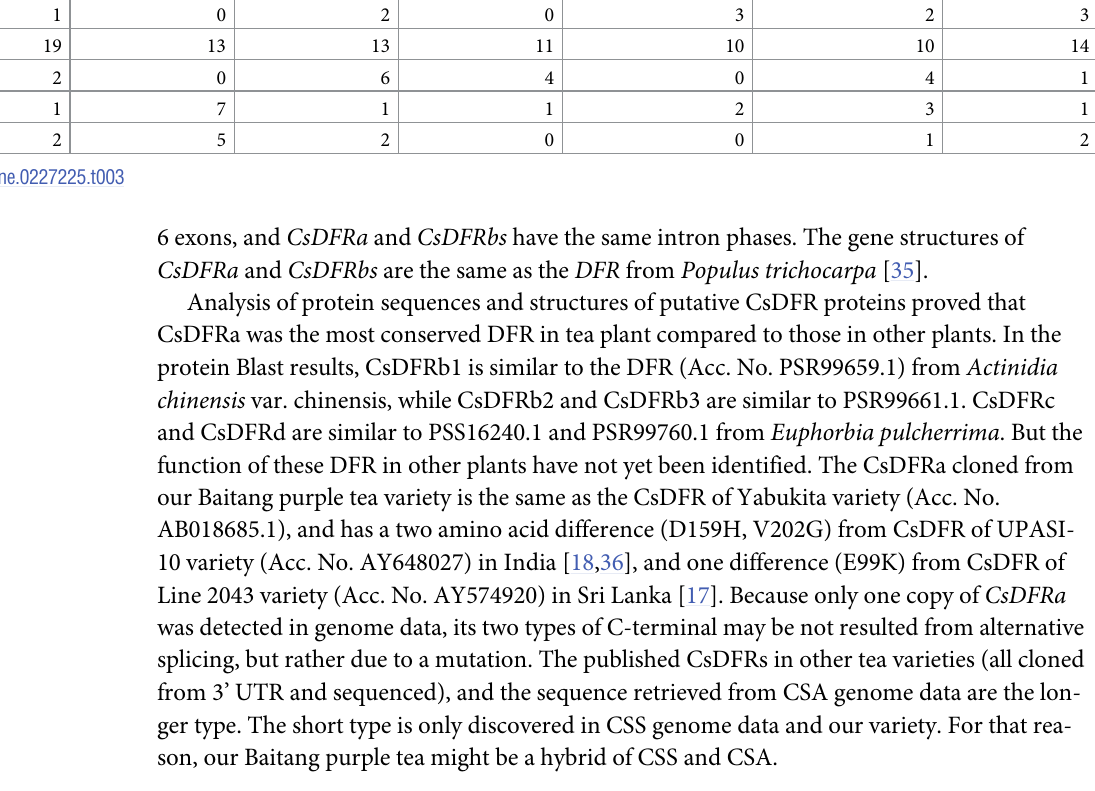
Table 3. Counts of cis-elements of putative CsDFRs responding to hormones and stresses.